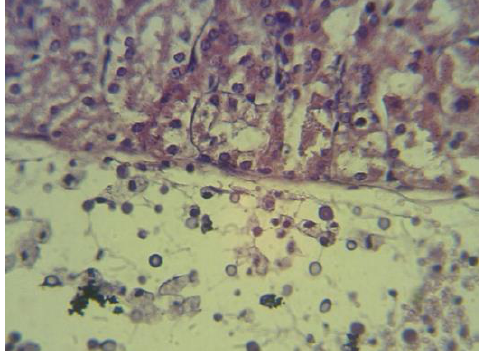
Figure, 4: Histopathological section in the kidney of animal at - 3days post-infection shows yeast cells in capsular region with few neutrophils, eosinophils and mononuclear cells infiltration well as acute cellular degeneration of renal tubules (H&E